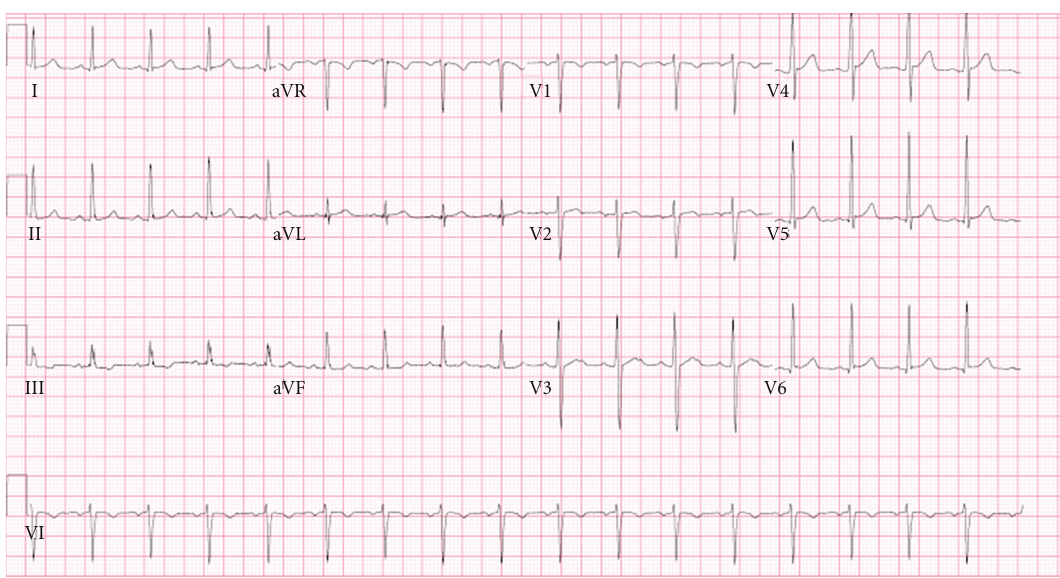
Figure 1: Electrocardiogram on day of chest pain onset: sinus tachycardia with no ST segment changes.